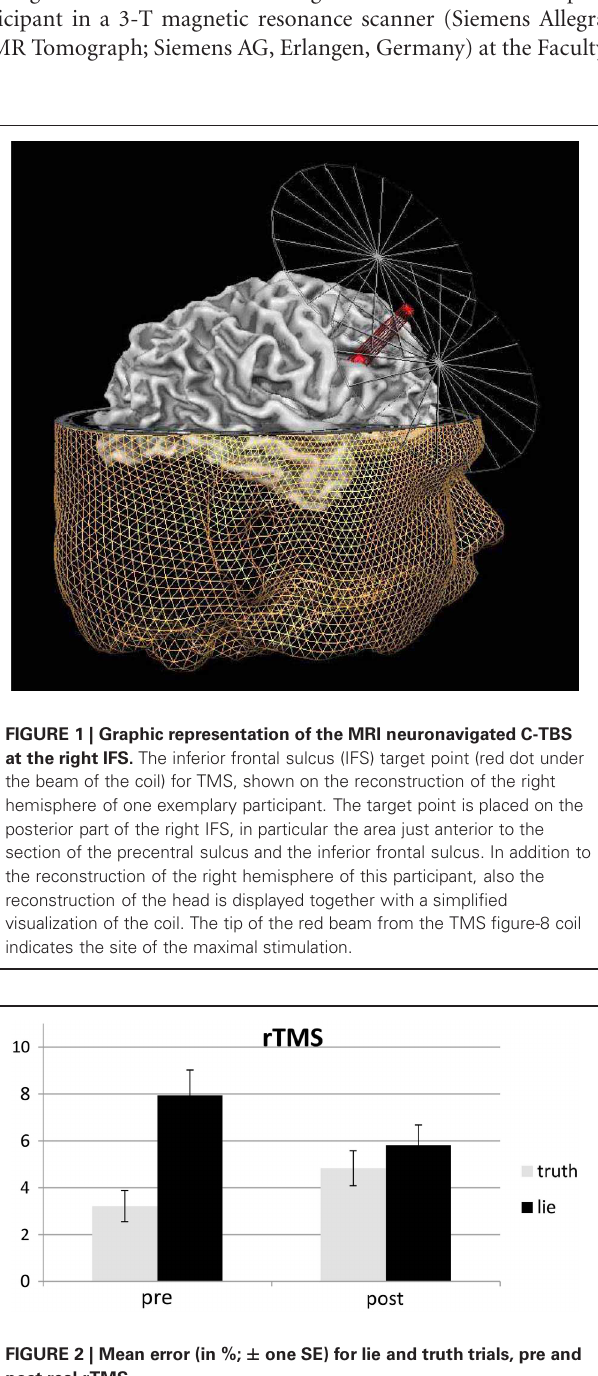
FIGURE 3 | Mean error (in %; ± one SE) for lie and truth trials, pre and post